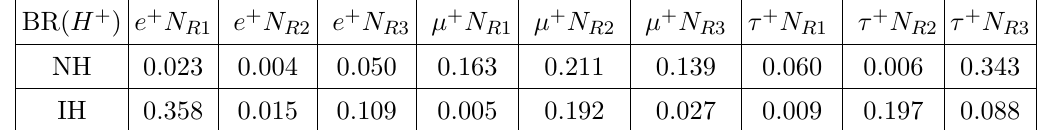
Table 1 . Branching ratios of the charged scalar H + into ‘ + N Ri for NH and IH at m and ! ij = 0 :